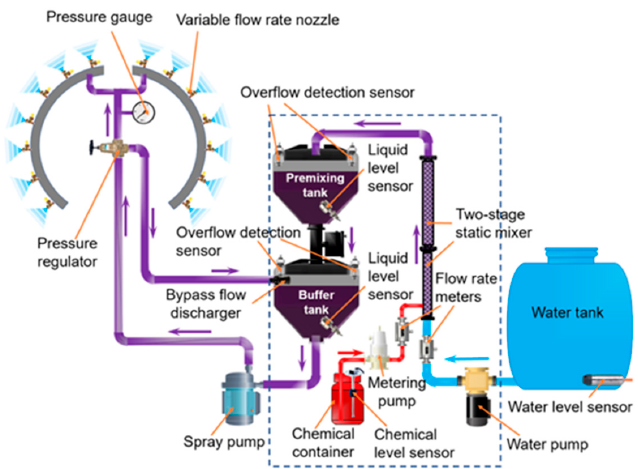
Figure 7. Schematic diagram of the premixing in-line injection system [84].